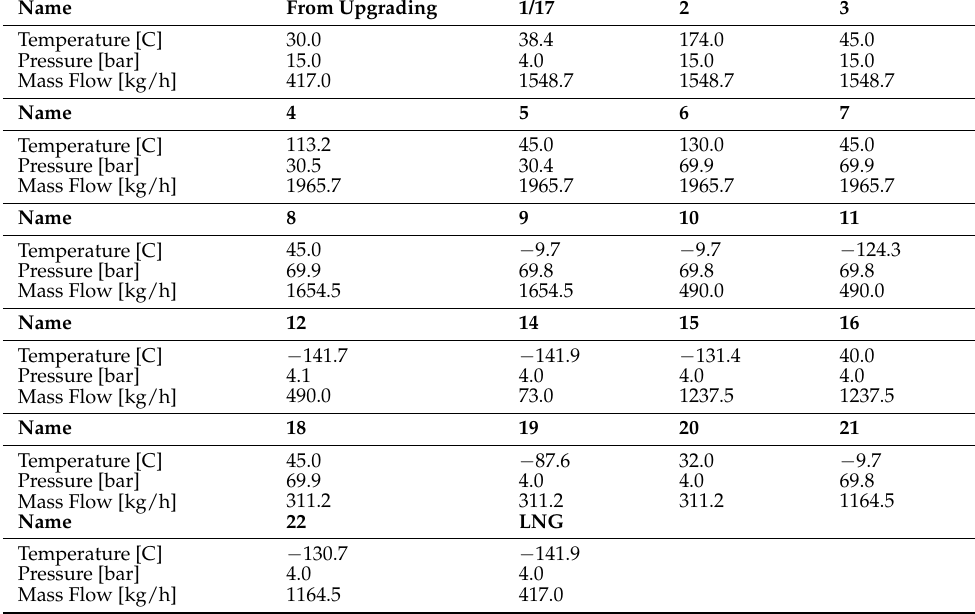
Table A3. States of the biomethane flows in DE.